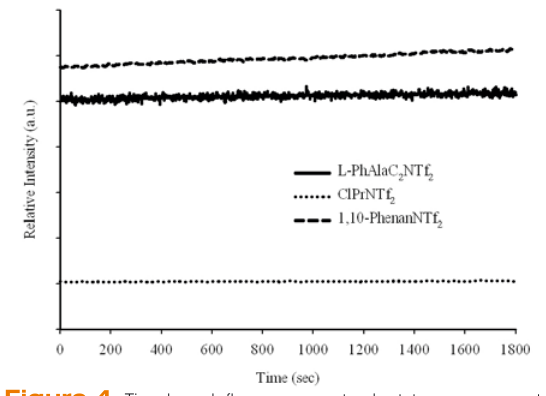
Figure 4. Time-based fluorescence steady-state measurements of 10 μM L-PhAlaC NTf , ClPrNTf , and 1 μM 2 2 2 1,10-PhenanNTf in ethanol, acquired with excitation and 2 emission bandpass set at 15 and 5 nm,